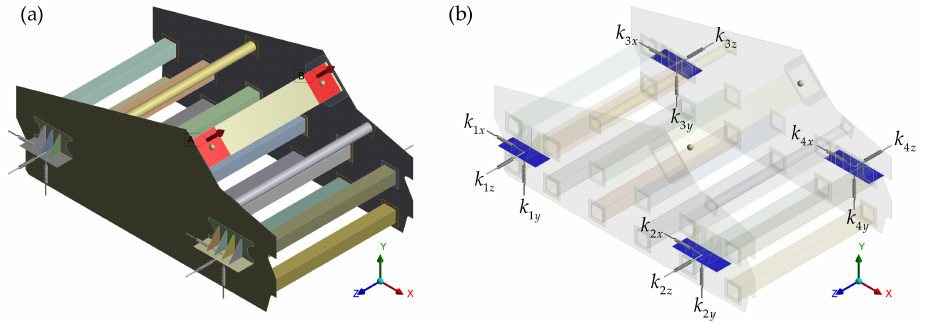
Figure 3. The overall finite element model of the mining vibrating screen. ( a ) POINT MASS units and alternating forces are applied on region A and region B. ( b ) Diagram of elastic supports.